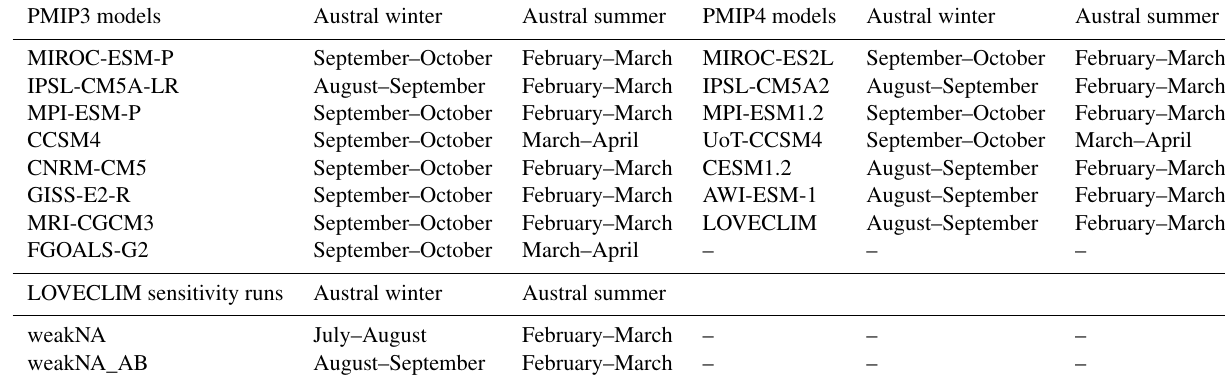
Table 2. Austral winter and austral summer months used for each